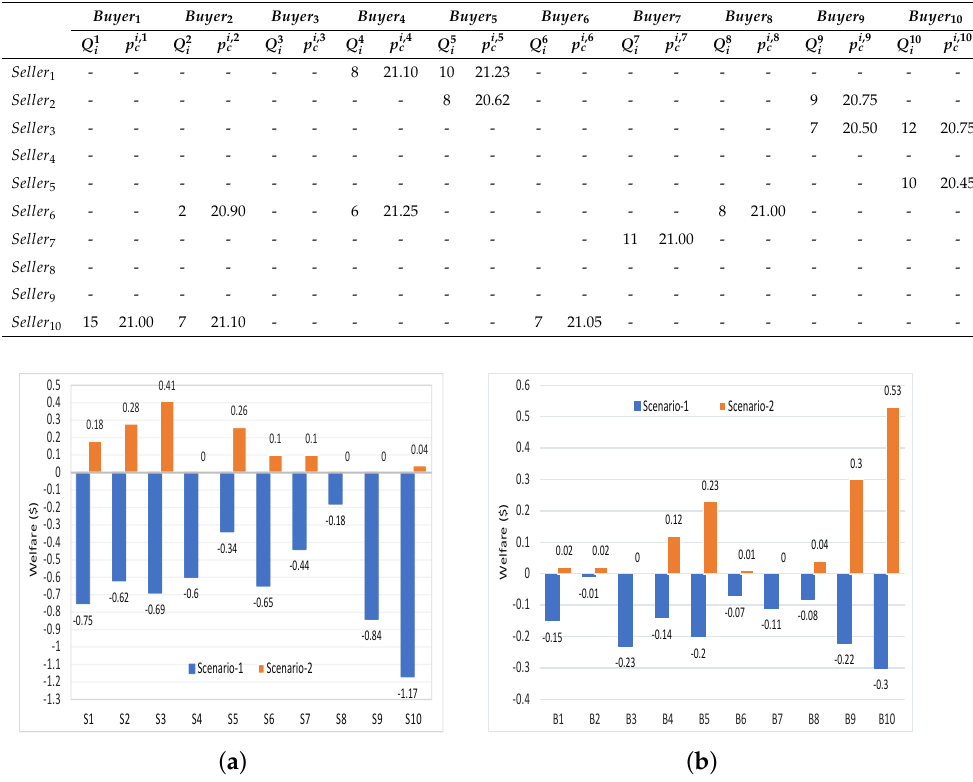
Table 5. Energy allocation and clearing prices in time slot s .